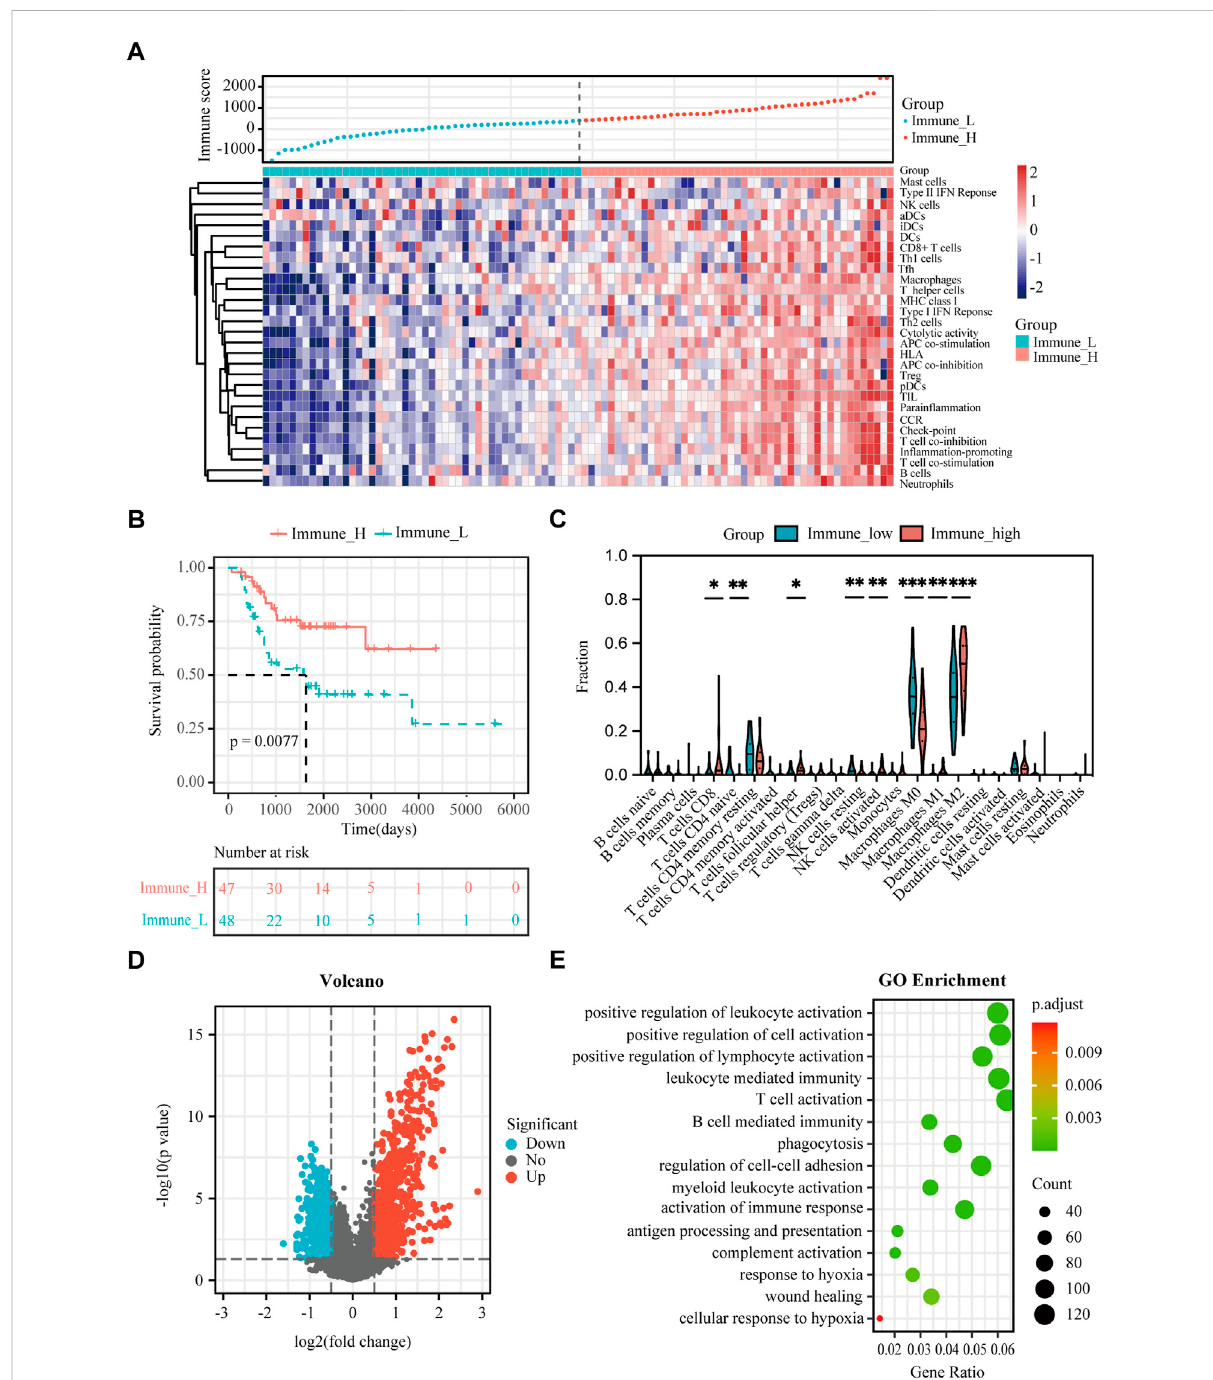
FIGURE 2 Analysis ofimmunestatus and immune-associated DEGs in osteosarcoma. (A) Enrichment levelsof 29 immune signatures inthe immune-high andimmune-lowgroups intheTARGET dataset. (B) K-Mplotofoverall survivalfor patientsinimmune-highandimmune-lowgroups intheTARGET dataset. (C) Comparison of 22 in fi ltrating immune cells between immune-low and immune-high groups in the TARGET dataset. (D) Volcano plot showingtheDEGsbetweenimmune-highandimmune-lowgroupsintheTARGETdataset. (E) GOanalysisofDEGsbetweenimmune-highand immune-low groups in the TARGET dataset. Asterisks mark statistically signi fi cant difference. * p < 0.05, ** p < 0.01, *** p <